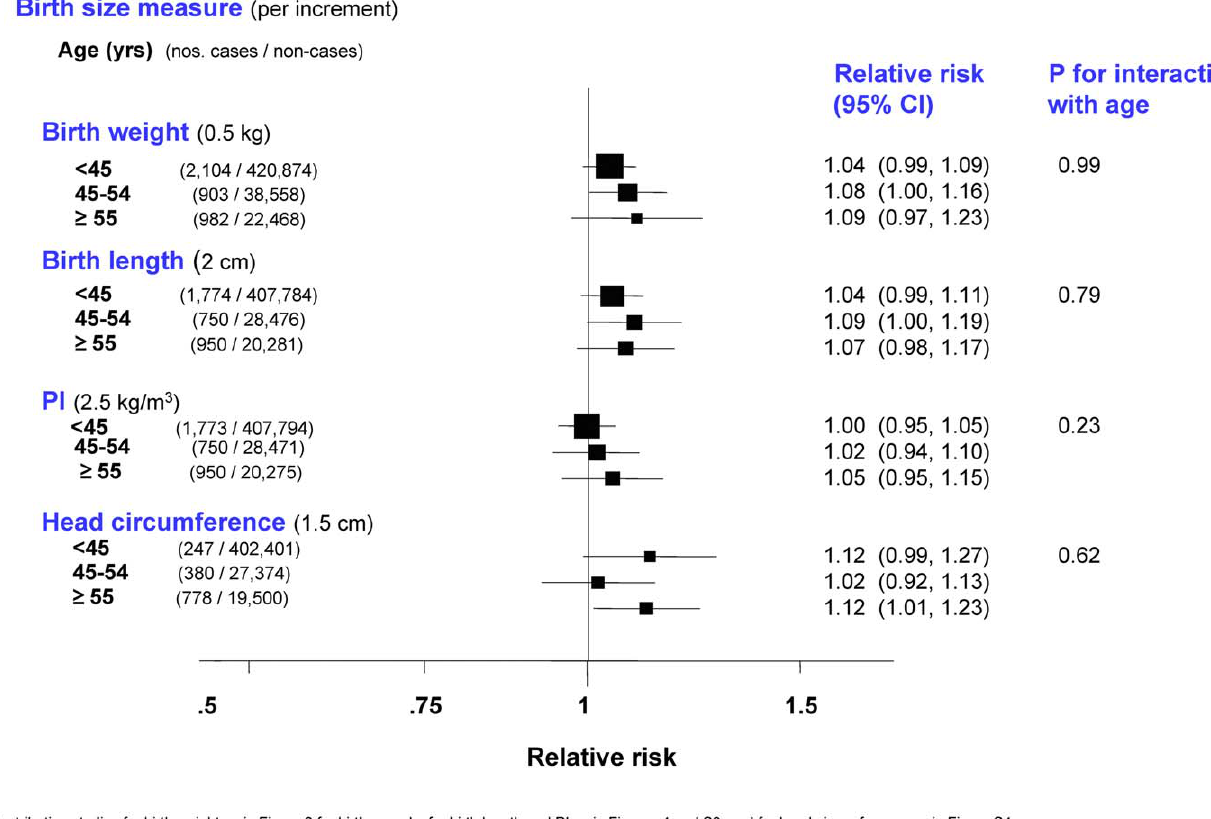
Figure 7. Minimally Adjusted Pooled Breast Cancer RRs in Relation to Continuous Weight, Length, PI, and Head Circumference at Birth Stratified by Age (Restricted to Singleton Studies Based on Birth Records)